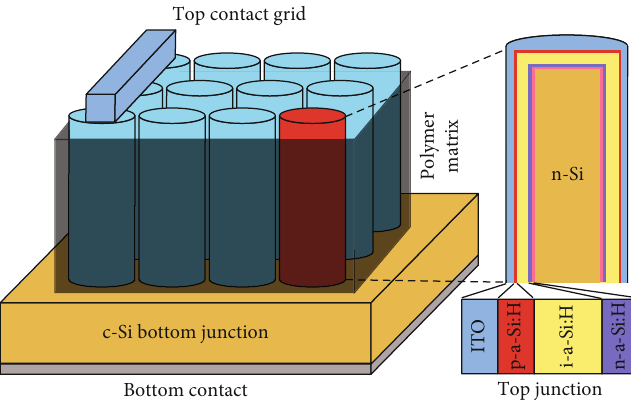
Figure 1: Schematic representation of a nanowire-based solar